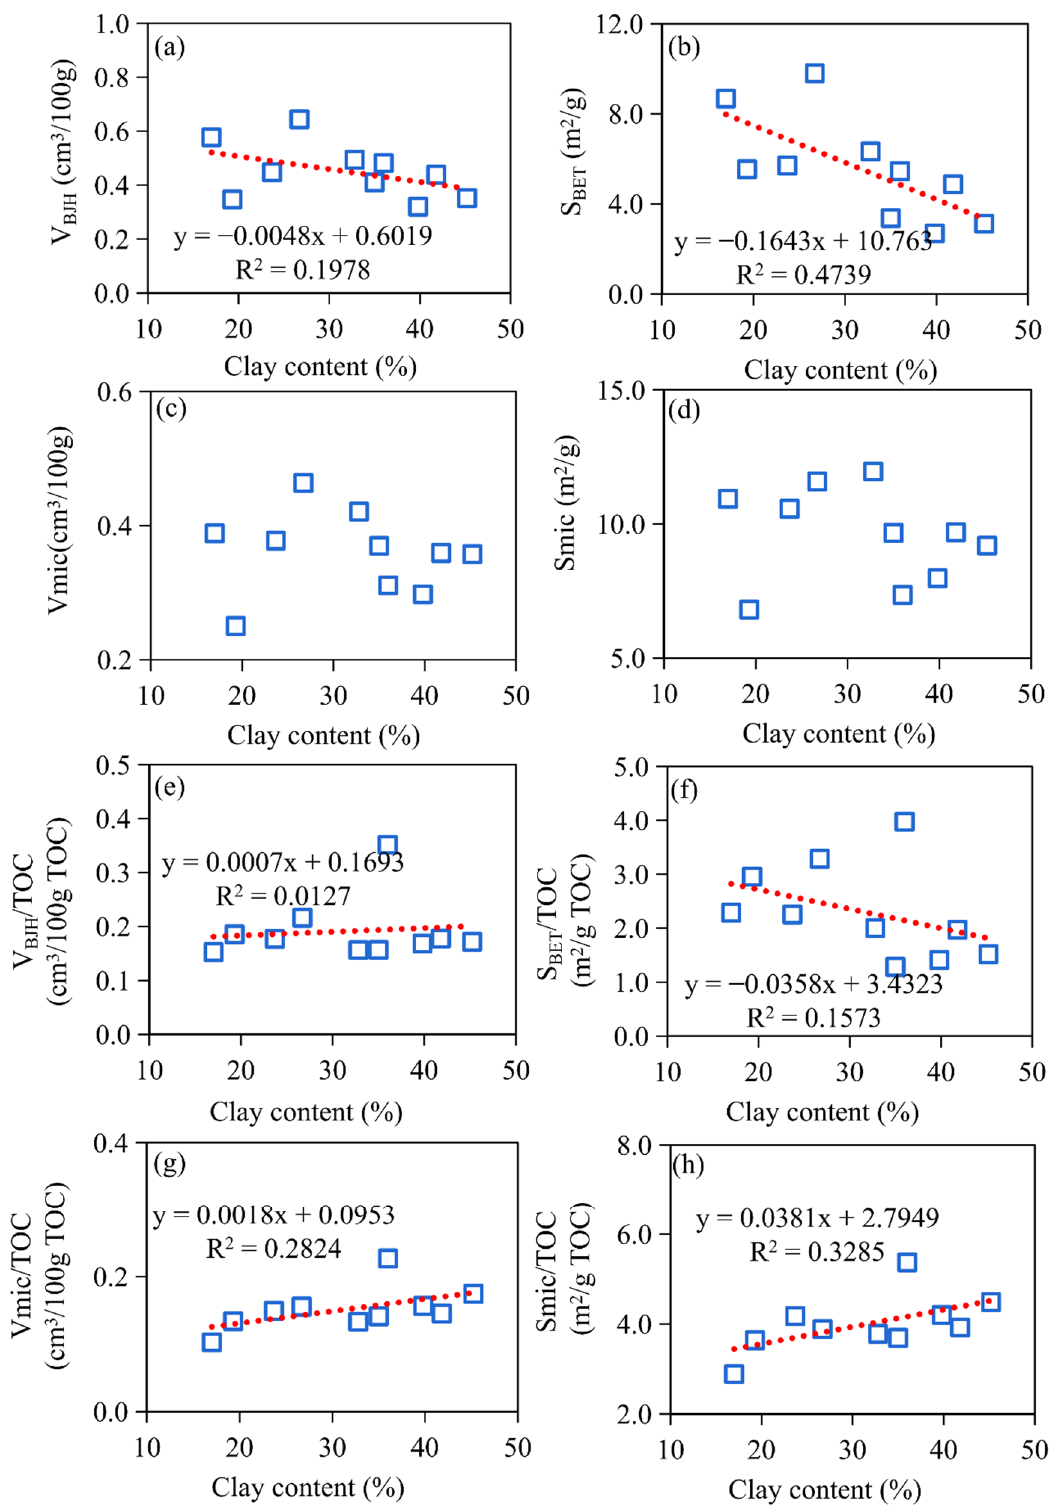
Figure 13. Relationships of clay mineral content with pore structure parameters ( a – d ), and pore structure parameters/TOC (ratios of pore structure parameters to TOC) ( e – h ) for the YC2 samples. See details in text.